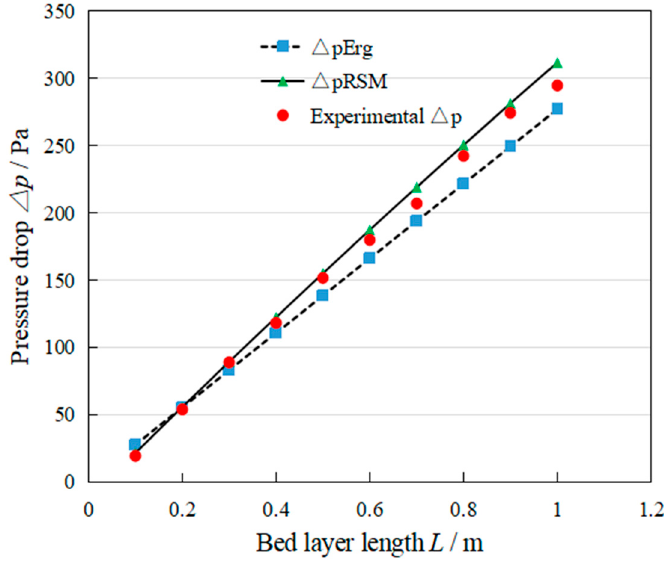
Figure 9. The variations of ∆ p with L under the constant v air of 0.35 m/s and Mc of 18.9 %w.b. Table 7. The statistical results for the single factor experiments.